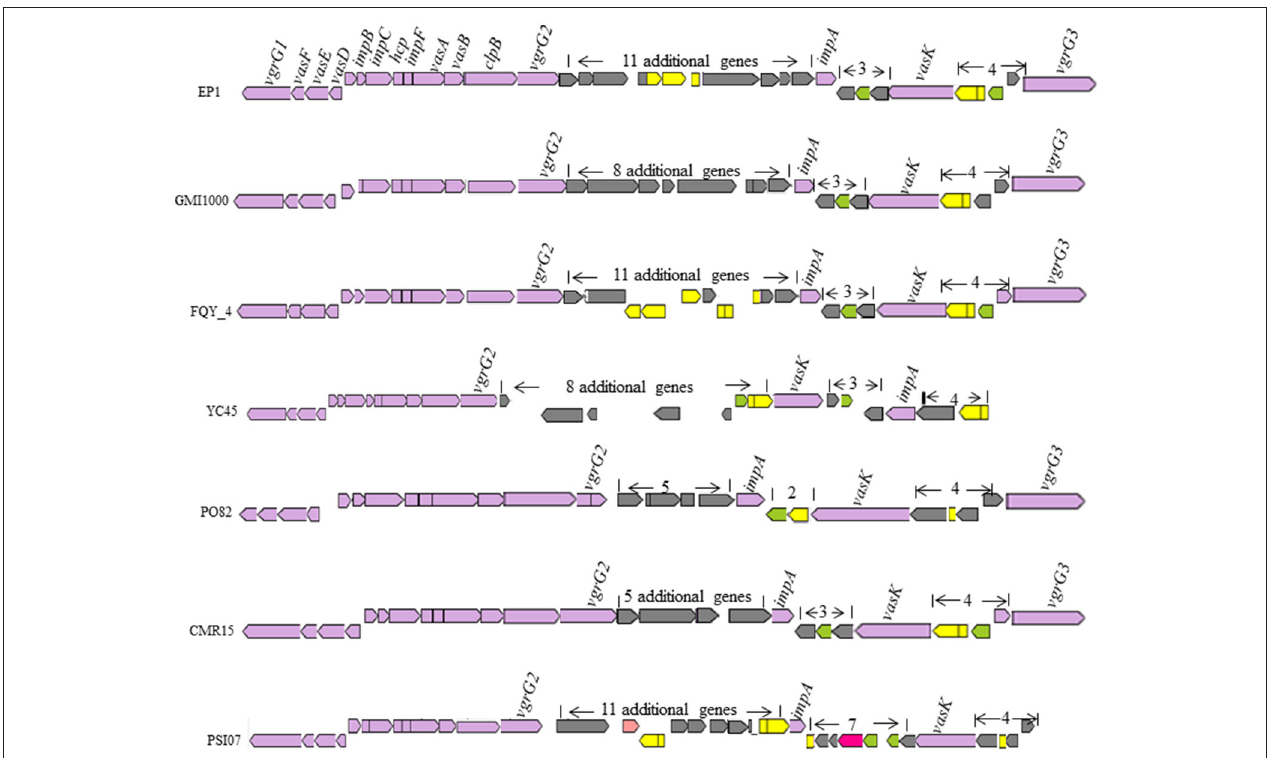
FIGURE 9 | Genetic organization of T6SS clusters in R. solanacearum